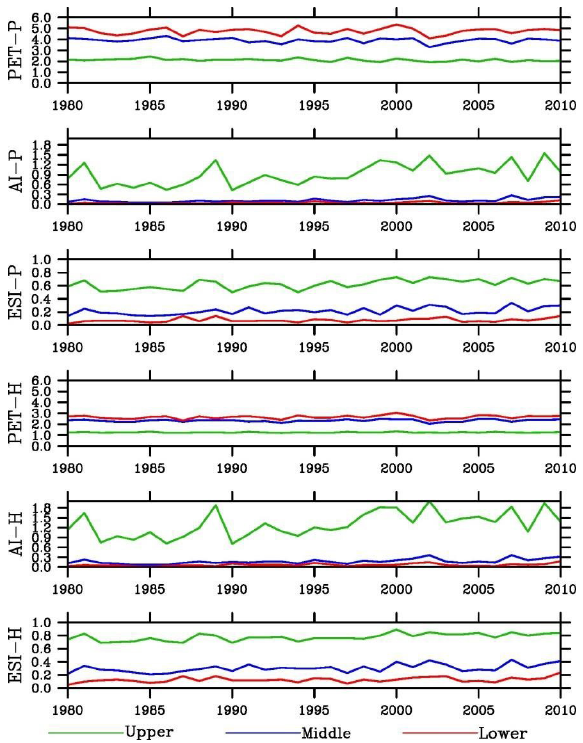
Figure 9. Interannual variations of potential evapotranspiration (mmd − 1 ), aridity index, and evaporative stress index. P and H in- dicate the Penman–Monteith and Hamon method,